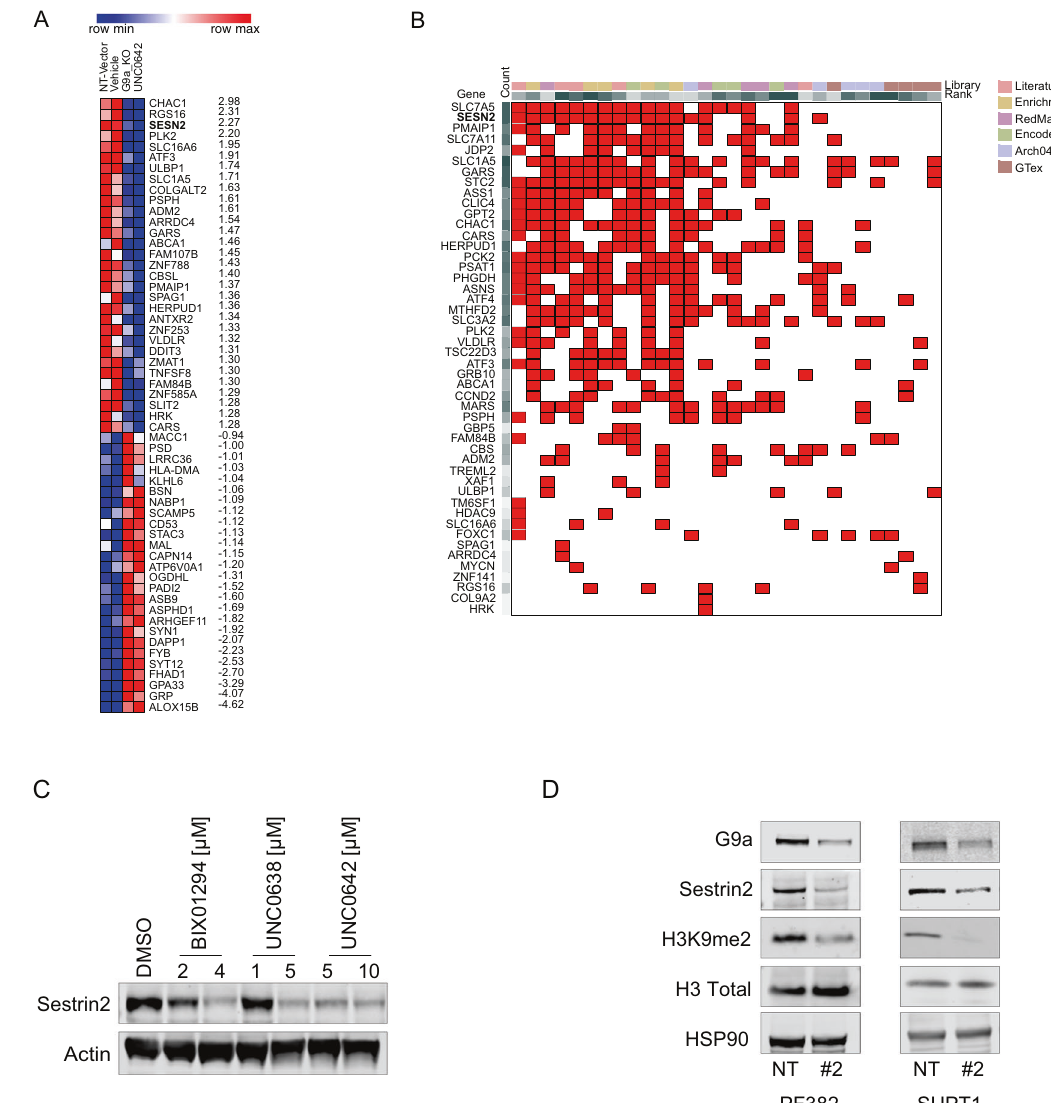
Fig. 4 Transcriptional consequences of G9a loss in T-ALL. A Heatmap showing mRNA expression of differentially expressed genes in non- targeting sgRNA (sgNT), sgRNA targeting EHMT2 (#2) or T-ALL cells treated either with vehicle or UNC0642 ( P < 0.05 and Log 2 fold changes > 1.5) and ranked for signal to noise ratio (snr). Each column represents the mean of two biological replicates per condition. B Clustergram showing transcription factor enrichment analysis (TFEA). G9a loss gene set from ( A ) was compared to the ChEA3 benchmark libraries as listed in https://amp.pharm.mssm.edu/chea3/#top for TF target over-representation analysis. Red boxes show the overlapping query gene targets among top library results. C Western blot showing expression of sestrin2 in PF382 cells treated at the indicated concentrations of G9a inhibitors after 48 h. Actin was used as a loading control. D Western blot showing expression of G9a/ EHMT2 , sestrin2, H3K9me2, and H3 Total, in PF382 and SUPT1 cells after 2 days post sgRNA selection. HSP90 was used as a loading control. NT non targeting; #2 = sgRNA #2 directed against EHMT2 lysosome fusion (Supplementary Fig. 8A). Similarly, G9a inhibition increase in the microtubule-associated light chain 3 (LC3) form (II) triggered autophagy in cells growing in 3D matrices (Supplemen- protein levels bound to autophagosomes at 48 h post-treatment tary Fig. 8B – E). Furthermore, genetic suppression of G9a levels (Fig. 6C). These effects were not seen in T-ALL treated with (Fig. 6E) caused the formation of autophagic acidotropic vesicles in chemotherapy or targeted agents (Supplementary Fig. 7B, C). T-ALL cell lines (Fig. 6F). Because glycogen accumulation may result In addition to autophagosomes, identi fi ed by the presence of a in disruptive autophagosomes and lysosomes formation/degrada- double membrane, TEM analysis revealed an increased number of tion cycle [35] we repeated the acidotropic staining in the presence lysosomes (Supplementary Fig. 7D). or absence of 2-Deoxy-d-glucose (2-DG) to lock the activity of To provide further evidence of induction of autophagy by G9a hexokinase and inhibit the access of glucose for glycolysis and inhibitors in T-ALL cells, we performed acidotropic staining with glycogen formation. As shown in Supplementary Fig. 8F the LysoTracker Red dye and observed a signi fi cant increase in the addition of 2-DG rescues the autophagosome formation suggesting number of acidic vesicles, indicative of autophagosome/lysosome that the accumulation of glycogen is partially responsible for the fusion in cell lines (Fig. 6D), a process reverted with the addition of observed phenotype in G9a treated cells. Ba fi lomycin A1 a known inhibitor of autophagosomes and